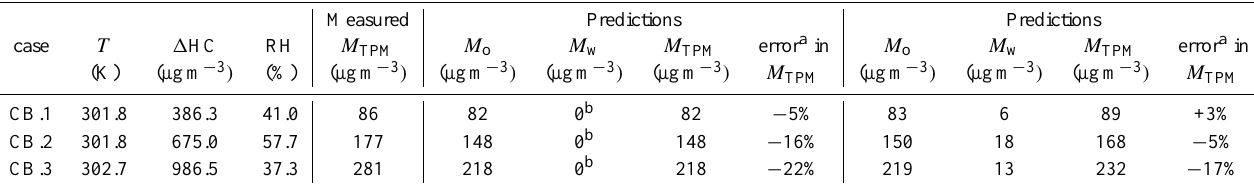
Table 2. Results for chamber-based (CB) cases with α -pinene/O 3 as measured by Cocker et al. (2001) and as predicted using the approach and using the approach with the CP-Wilson.1 method for prediction of ζ i values.